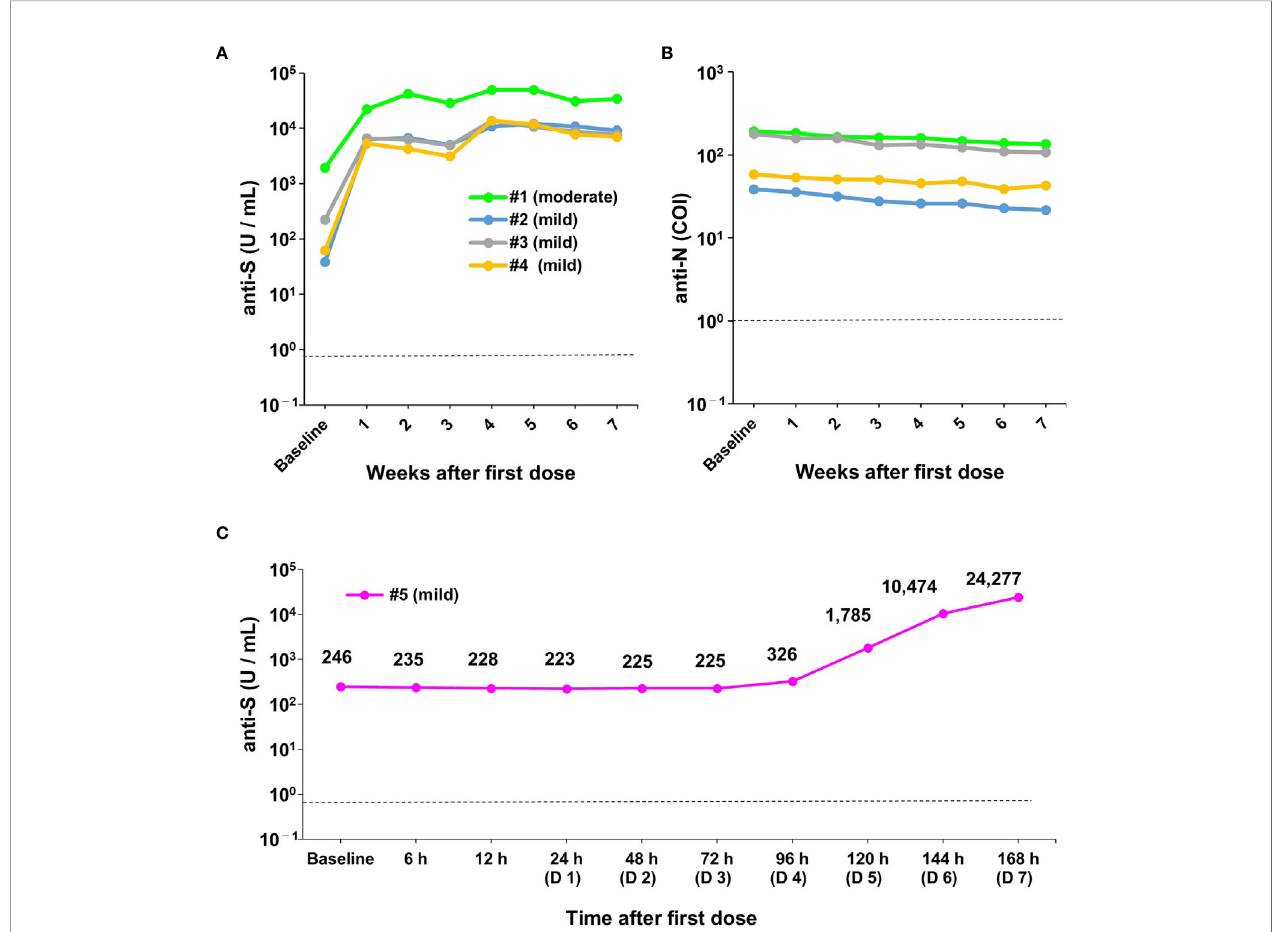
FIGURE 4 | Robust humoral immune responses after the fi rst dose of vaccine in previously infected healthcare workers. (A, B) Changes in antibody titres on a weekly basis (weeks 1 to 7) in previously infected healthcare workers (HCWs) (n=4) after the fi rst dose of vaccine. Data show changes in anti-spike (S) (A) and anti- nucleocapsid (N) antibody titres (B) . During the previous infection, one of the four HCWs had moderate symptoms (individual #1) and three had mild symptoms (individuals #2, 3, and 4). (C) Changes in antibody titres on an hourly basis after the fi rst dose of vaccine in one previously infected HCW (#5). During the previous infection, this HCW had mild symptoms. The upper left fi gure shows a magni fi ed view of the data from baseline to 96 hours (day 4). COI, cut-off index; h, hour; D, day. The dotted line indicates the cut-off value (0.8 U/mL for anti-S and 1.0 COI for anti-N